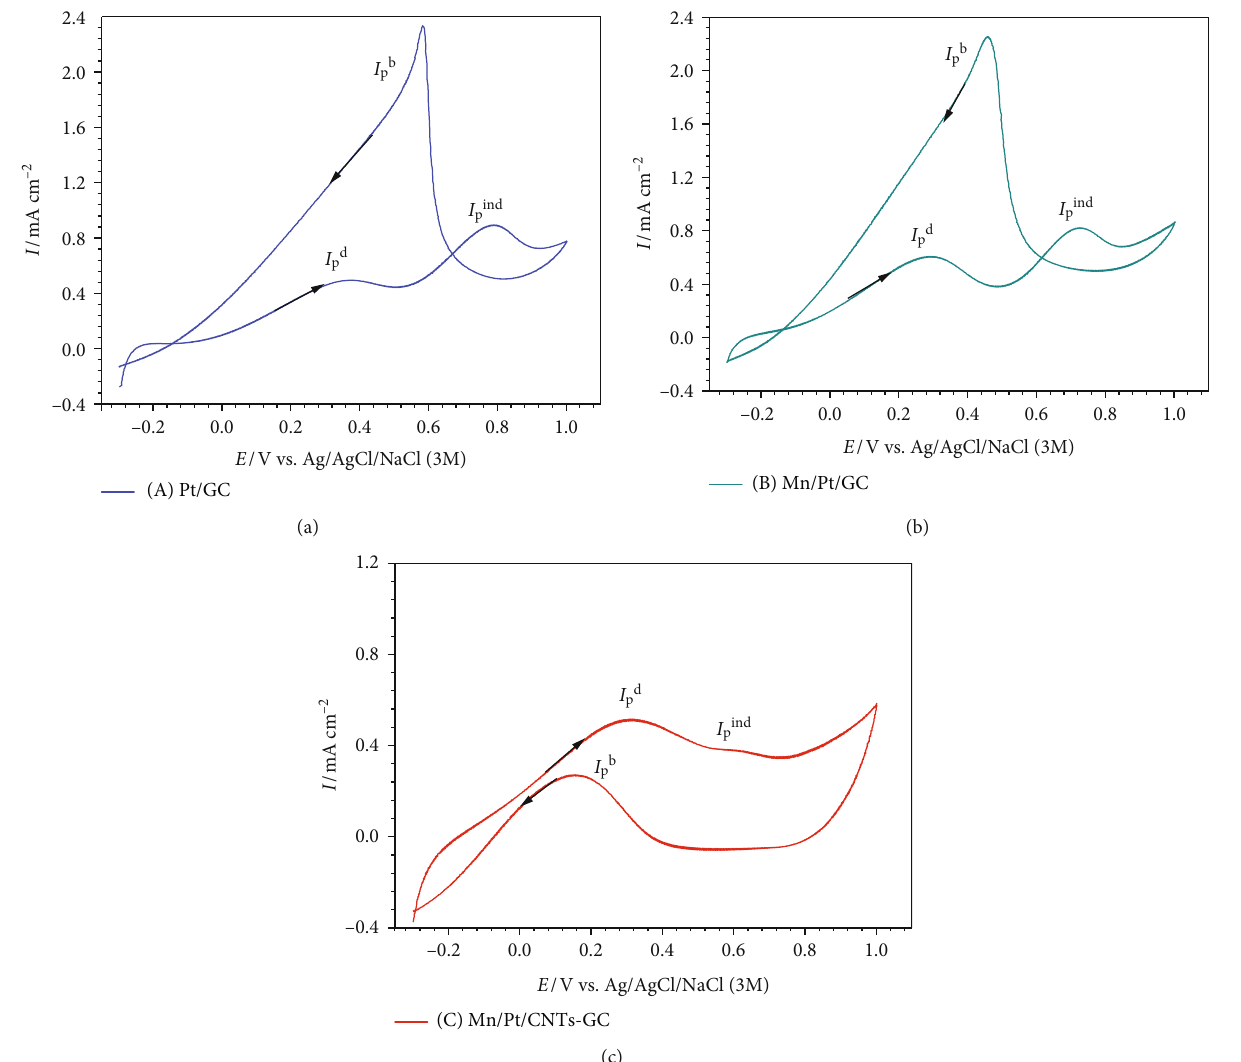
Figure 3: CVs obtained at the (a) Pt/GC, (b) Mn/Pt/GC, and (c) Mn/Pt/CNT-GC electrodes in 0.3 M FA ( pH = 3 : 5 ). Potential scan rate: 100mVs – 1